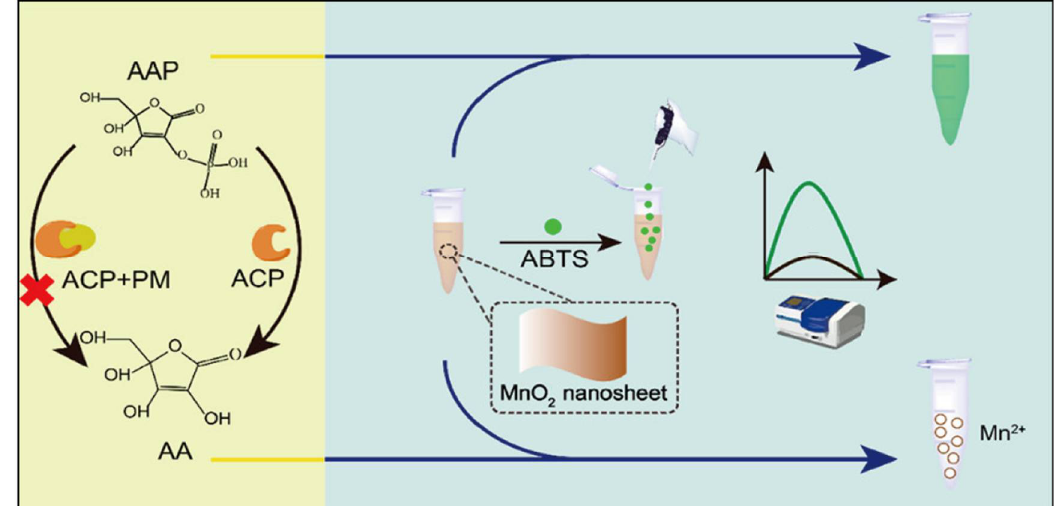
Figure 4. Generation of AA from ACP catalysis hinders nanozyme catalytic system for pesticide determination (reprinted with permission from [94], Copyright 2020, American Chemical Society